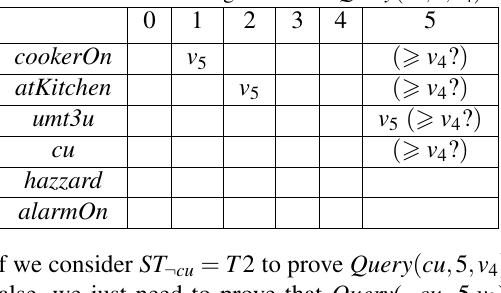
Table 9. The Searching Process of Query ( ¬ cookerOn , 1 , v 4 ) Table 10. The Searching Process of Query ( cu , 5 , v 4